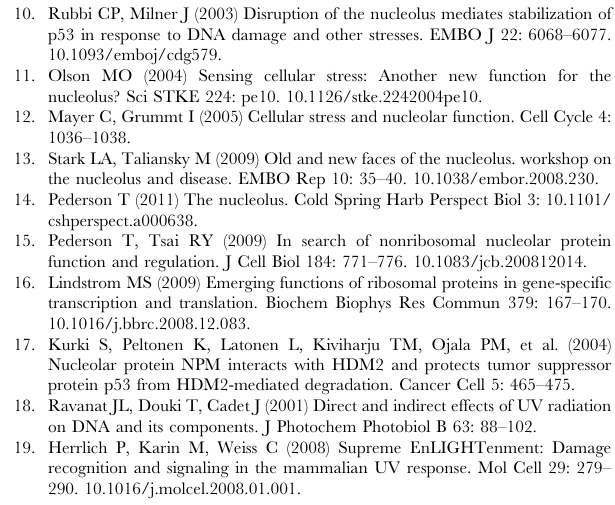
Figure S1 NPM nucleoplasmic mobility is high follow- ing UV radiation. A U2OS cells were transiently transfected with NPM-ECGFP and were treated with UVC (35 J/m 2 ) for 6 hours. FRAP analysis was performed on nucleoplasm as indicated by ROI ( red circle). Following photobleaching images were captured every 1 s for 100 s. Representative images are shown. Scale bar 10 m m. B Averages of normalized intensities and the mobile fraction from at least two independent experiments is shown. Error bars, SD. N =10 cells. Figure S2 Inhibition of DNA damage or UV-activated cell stress signaling pathways do not affect UV-mediated NPM relocalization. U2OS cells were treated with inhibitors targeting UV-activated cellular signaling (U0126 10 m M for MEK, SB203580 20 m M for p38 and SP600125 100 m M for JNK), DNA damage signaling (KU55933 10 m M for ATM, wortmannin 100 m M for ATM/ATR and NU7441 10 m M for DNA-PK) and proteasome (MG132 10 m M) or left untreated. One hour later the cells were exposed to UV radiation (35 J/m 2 ) or left untreated. Cells were fixed after 3 hours and stained for NPM. Scale bar, 50 m m. Figure S3 NPM relocalization is not antibody-specific and NPM protein levels remain constant in different cell lines. A U2OS cells stably expressing NPM-ECGFP were treated with MG132 or left untreated. After 2 hours the cells were treated with UV (35 J/m 2 ) and incubated for 6 hours. Scale bar 20 m m. B HeLa and U2OS cells were pretreated with MG132 and UV (35 J/m 2 ) as shown. After 3 hours cells were lysed with RIPA buffer. Equal amounts of total protein were separated by SDS- PAGE and immunoblotted for NPM. Tubulin was used as a loading control.